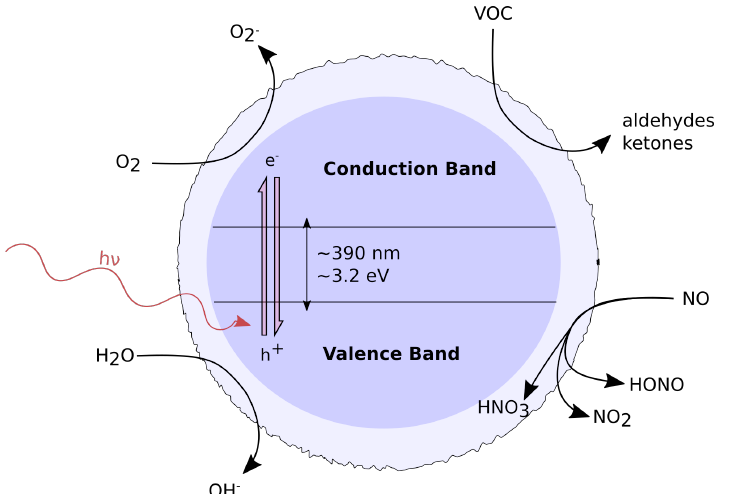
Figure 1. Excitation of TiO 2 and possible outcomes, VOC is Volatile Organic